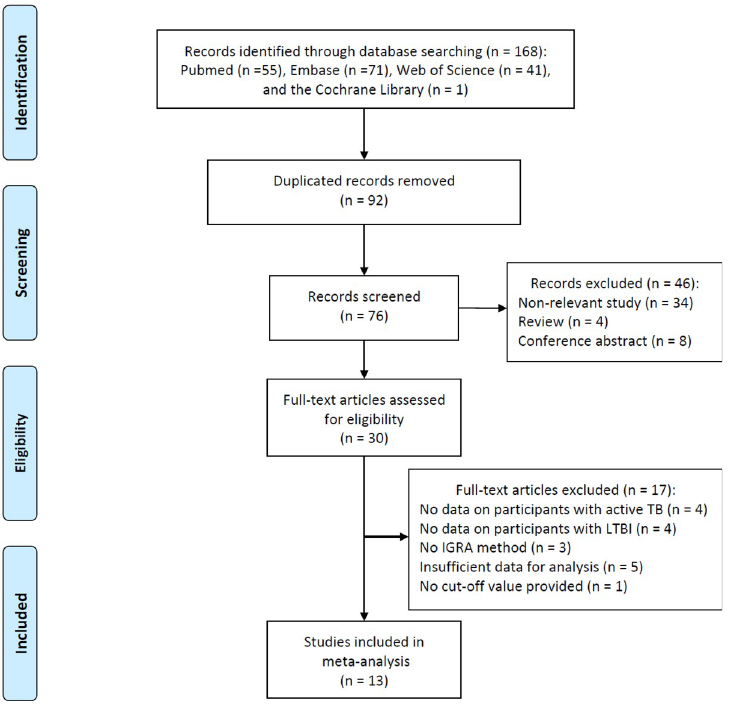
Fig 1. Flow diagram of the study screening